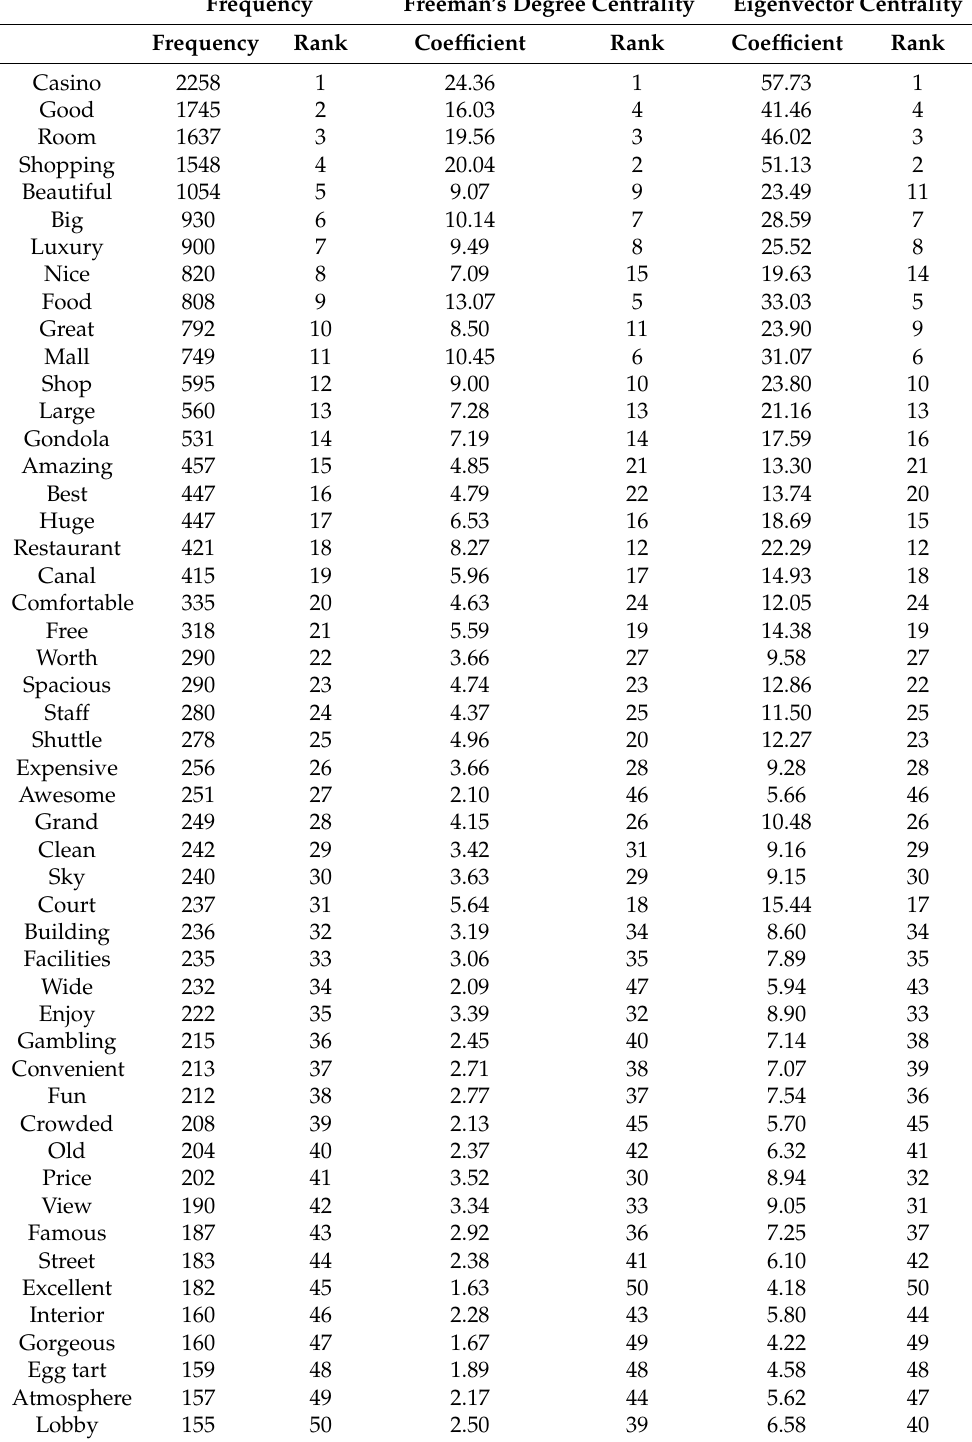
Table 3. Comparison of keywords frequency and centrality (The Venetian in